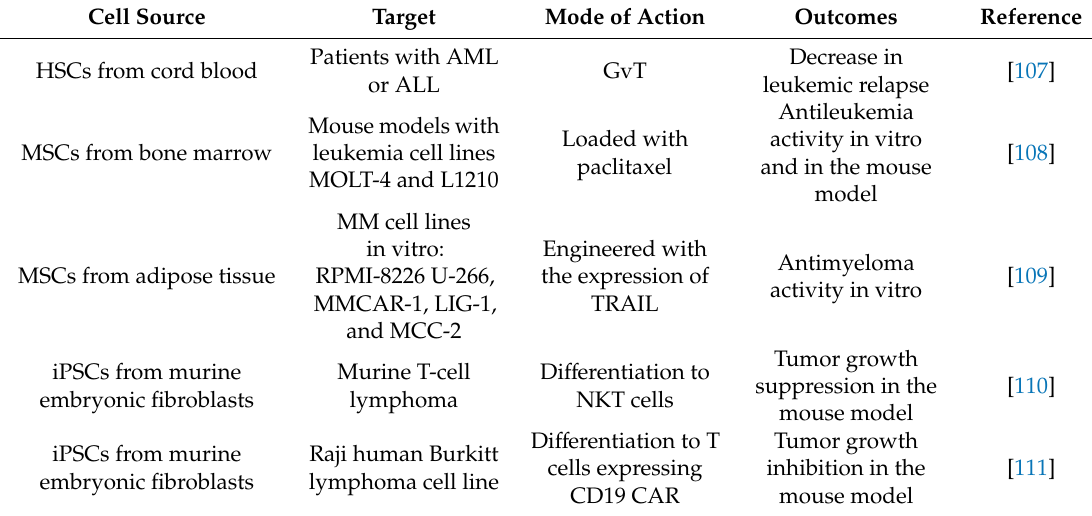
Table 2. Selected cell-based clinical trials and preclinical studies with stem cells to treat hematological malignancies, featuring key aspects. iPSCs: induced pluripotent stem cells, HSCs: hematopoietic stem cells, MSCs: mesenchymal stem cells, GvT: graft versus tumor e ff ect, TRAIL: TNF-related apoptosis-inducing ligand, and NKT: natural killer T